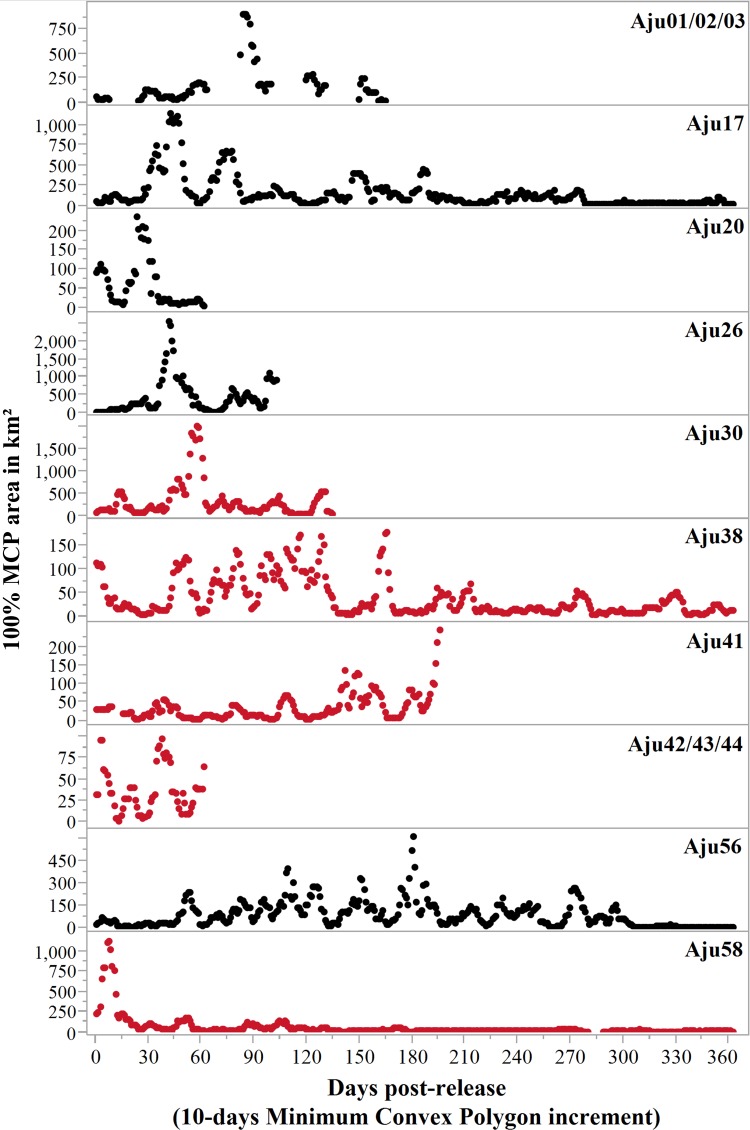
Progressive 100% Minimum Convex Polygon analysis for hard released (black curves) and soft released (red curves) cheetahs.Early deaths (<3 weeks) and case studies with insufficient movement records are excluded. Note: y-axis scales differ between case studies. Area estimates were only calculated if at least five data points were available for 10-day segments.